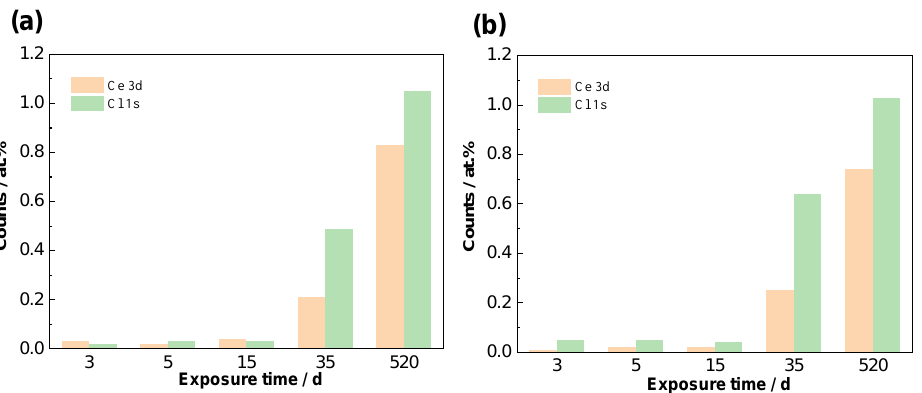
Figure 13. Quantitative analysis of XPS spectra of Al alloy substrate under single-layer coating and double-layer coating immersed in 3.5% NaCl solution for different times: ( a ) single-layer coating; ( b ) double-layer coating.